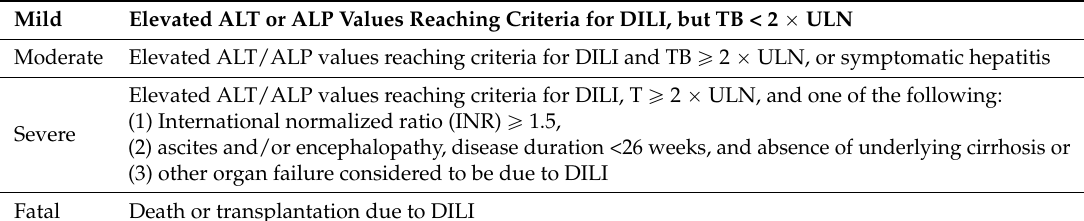
Table 2. Severity of